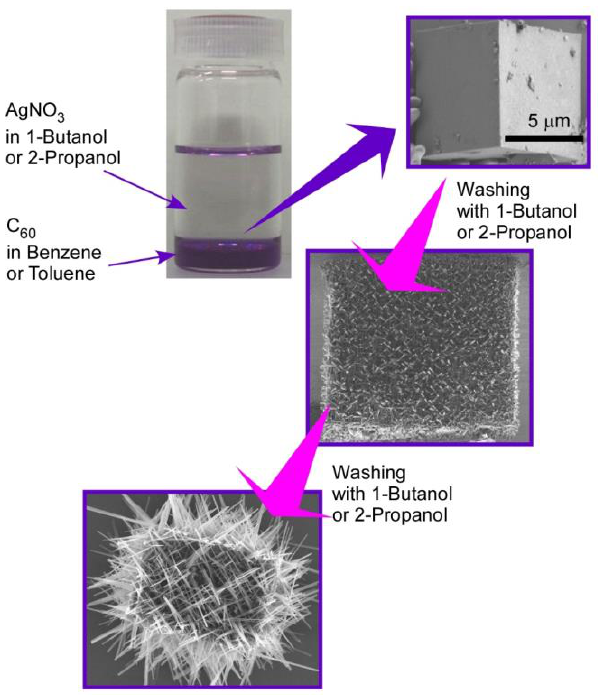
Figure 3. Hierarchic rods-on-cube structures of C 60 assembly fabricated through shape-shifting from micro-cube structures prepared with C 60 and AgNO 3 via the LLIP method.